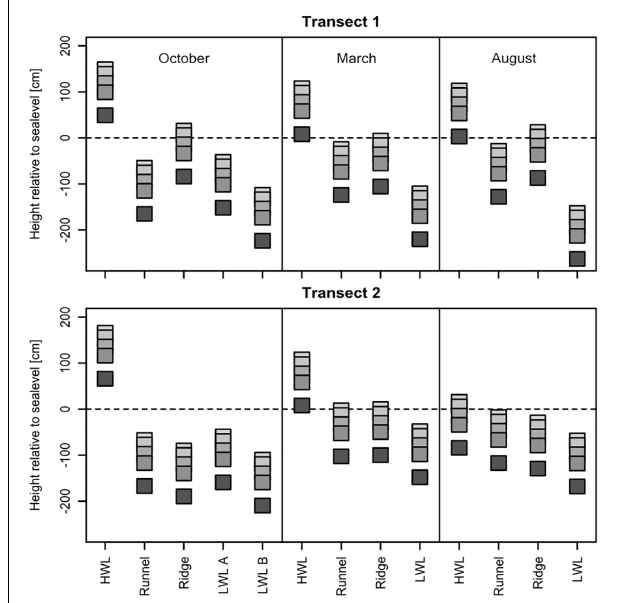
FIGURE 2 | Relative height to mean sea-level of the individual sediment cores during the different sampling campaigns in October 2016, March 2017, and August 2017. The squares represent the samples at 0, 10, 30, 50, and 100 cm depth, respectively. Displayed are both transects spanning the whole intertidal zone, with the sites high water line (HWL), runnel, ridge and low water line (LWL) sampled always at the same GPS coordinates for each season. Site LWL b, sampled in October 2016, was in the subtidal, and therefore not accessible, in March and